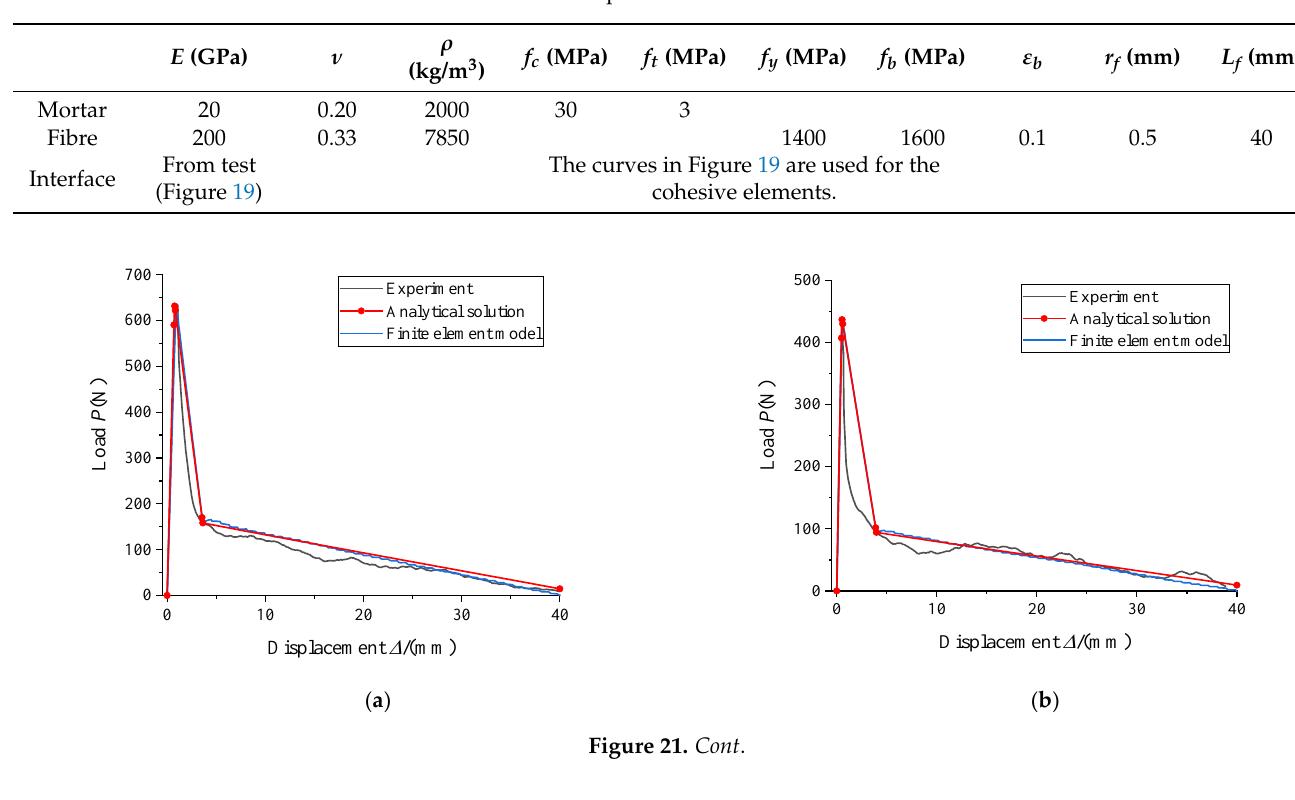
Figure 20. The finite element model of single pullout tests. Table 3. Material parameters in FE simulations.